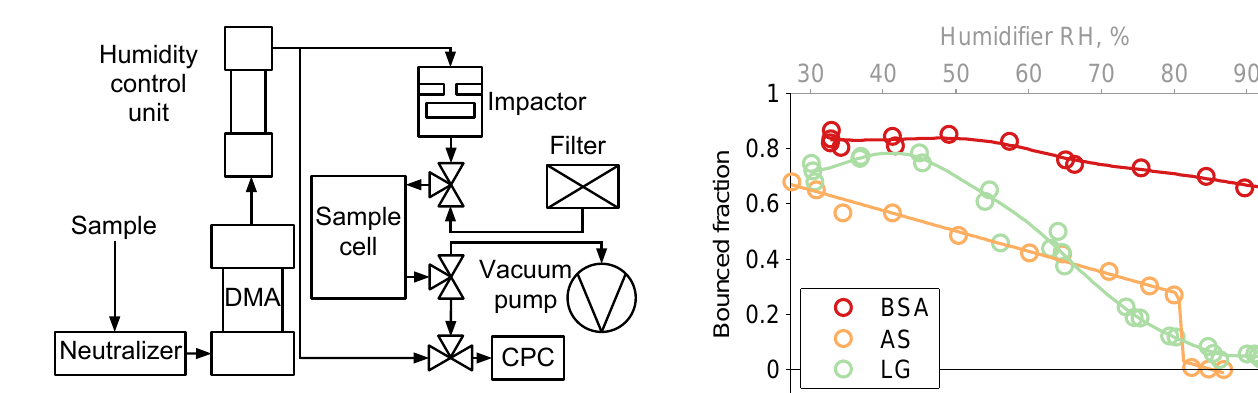
Fig. 2. The measurement system for the particle phase measure- ment.